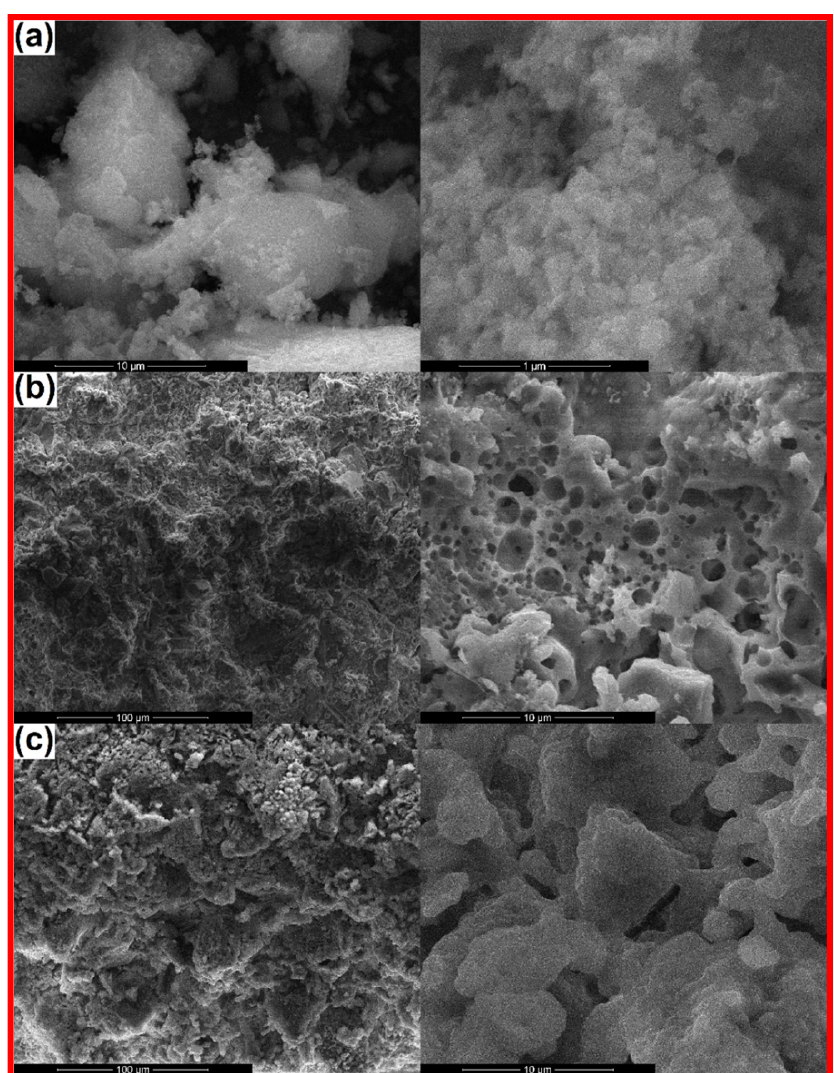
Figure 3. SEM images of: ( a ) Sm calcined powder (10,000× and 100,000×), ( b ) Sm-1000 sintered scaffold (1,000× and 10,000×) and ( c ) Sm-1200 sintered scaffold (1,000× and 10,000×).